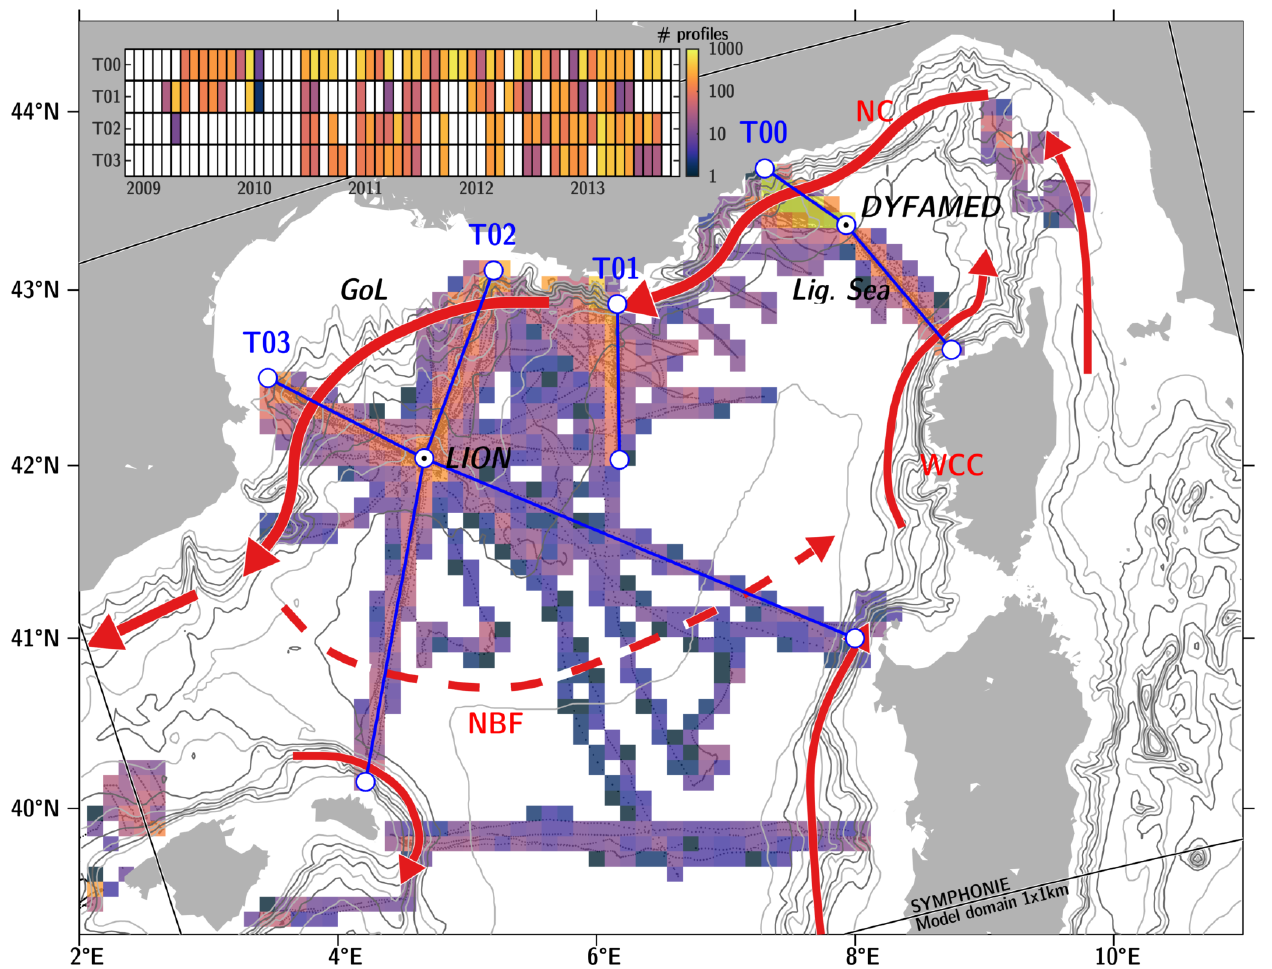
Figure 1. Maps of glider observations in the northwestern Mediterranean Sea from November 2008 to October 2013. The four endurance lines (T00, T01, T02 and T03) and mooring sites (LION and DYFAMED) are parts of the MOOSE (Mediterranean Ocean Observing System, https://www.moose-network.fr (accessed on 16 March 2021), see also Coppola et al. [86] for an overview). The color correspond to the number of profiles collected in 10-km boxes in the northwestern Mediterranean Sea. The upper panel further represents the monthly number of profiles collected along each endurance line during the study period. The main features of the circulation are represented by red arrows: Norther Current (NC), North-Balearic Front (NBF, in dashed line because of its variable and unstable pathway at mesoscale), West Corsica Current (WCC). GoL stands for “Gulf of Lion” and Lig. Sea for “Ligurian